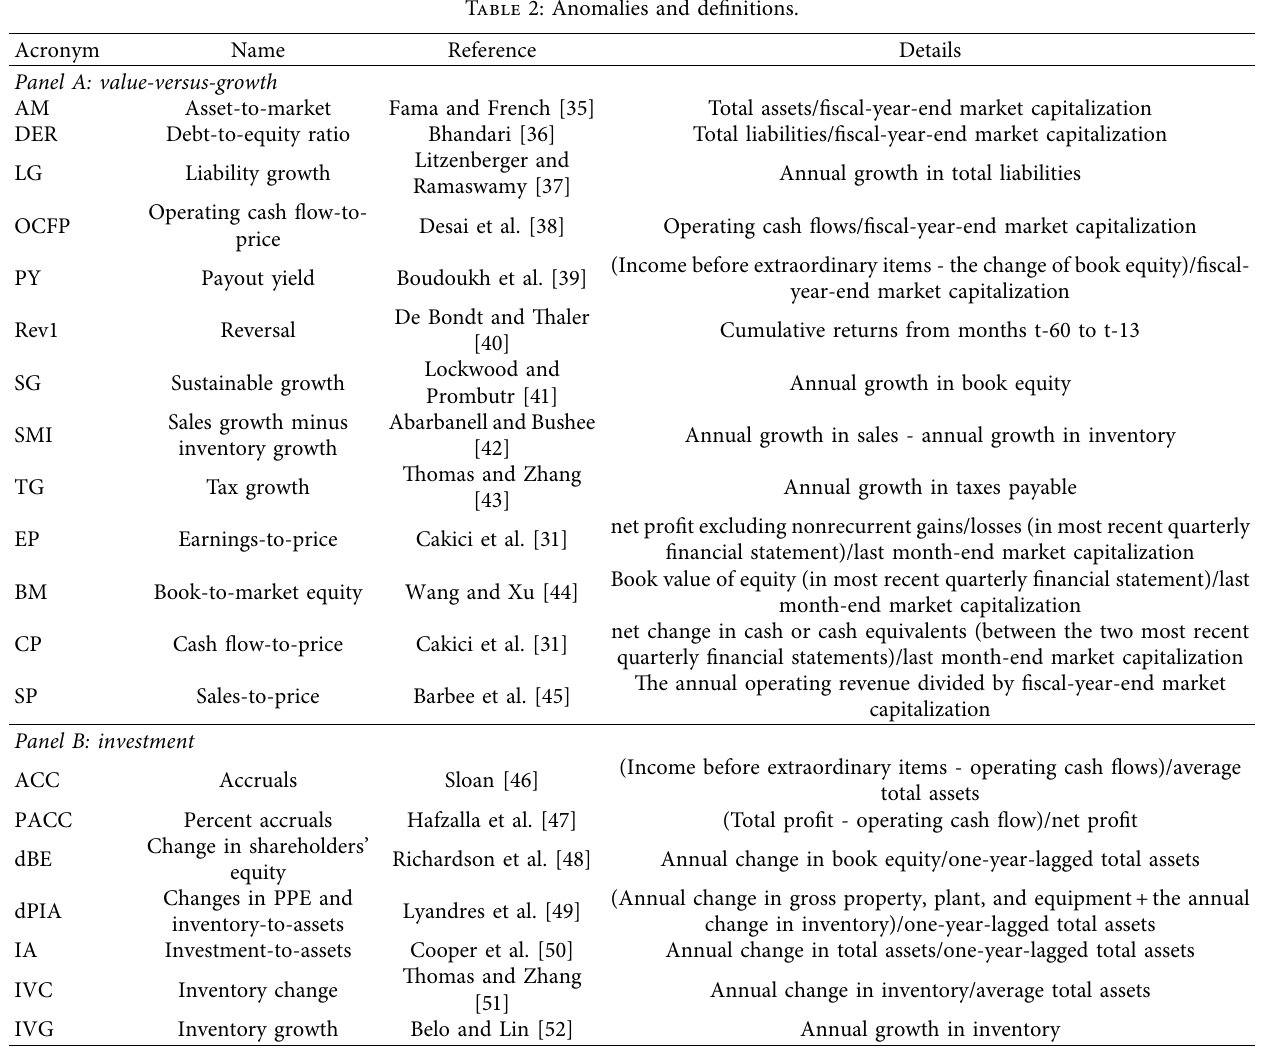
Table 2: Anomalies and